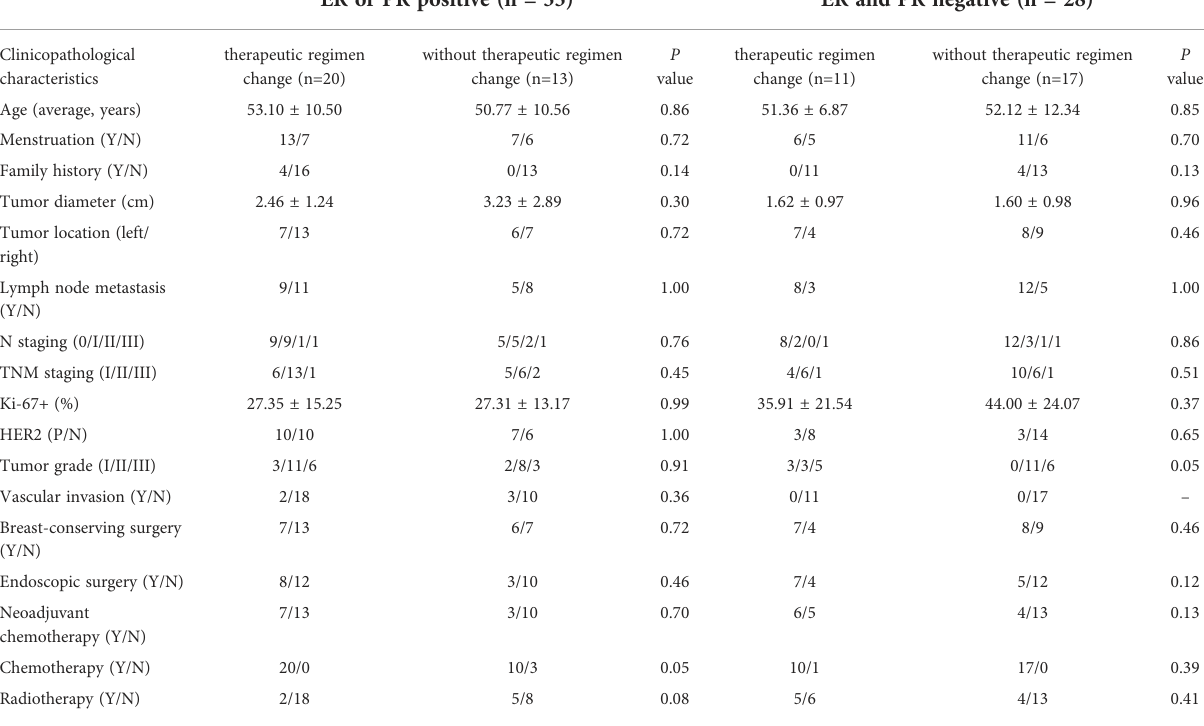
TABLE 1 The clinicopathological characteristics of patients who had a changed treatment regimen or